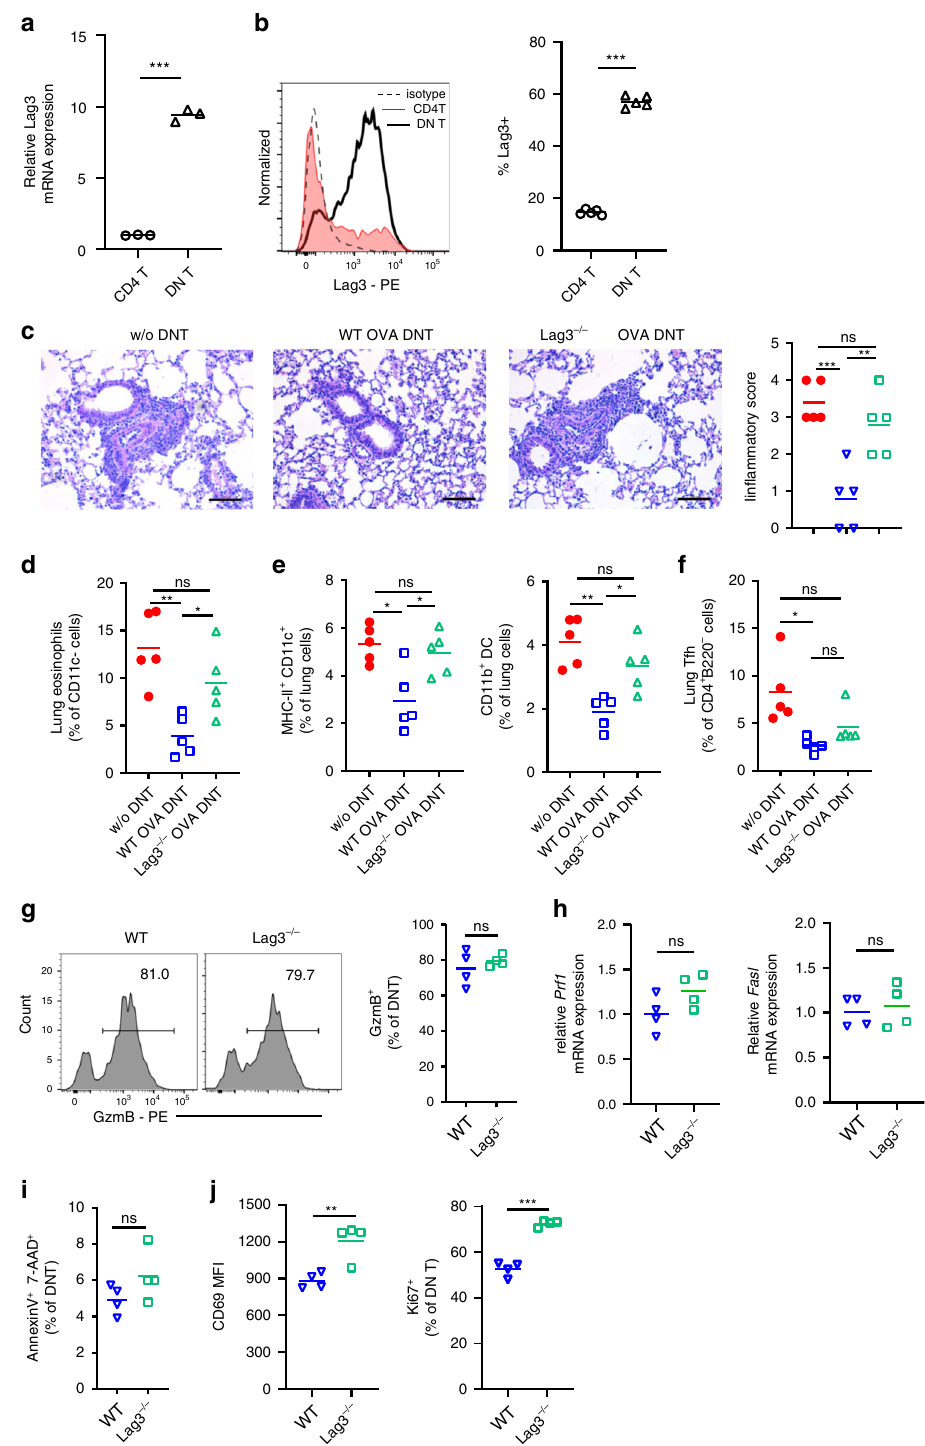
Fig. 6 Lag3 knockout reduced the antigen-speci fi c suppression of OVA DNTs. Relative Lag3 mRNA expression in OVA DNTs and CD4 + T cells was measured by a real-time PCR and b fl ow cytometry. Mice received WT OVA DNTs or Lag3 − / − OVA DNTs by intravenous adoptive transfer to treat OVA-induced airway in fl ammation. c Lung sections were stained with H&E to measure the accumulation of in fi ltrating in fl ammatory cells (Scale bars, 100 μ m). d Lung eosinophils (CD11b + Siglec F + CD11c - ), e DCs (CD11c + MHC-II + ), CD11b + DCs (CD11b + CD11c + MHC-II + ) and f Tfh cells (CD4 + B220 - CXCR5 + PD-1 + ) were assessed by fl ow cytometry. g GzmB expression in WT DNTs and Lag3 − / − DNTs were measured by fl ow cytometry. h Relative Prf1 and Fasl mRNA expression levels in WT DNTs and Lag3 − / − DNTs were measured by real-time PCR. i The apoptosis of DNT cells was detected by fl ow cytometry. j The expression of CD69 and Ki67 were detected by fl ow cytometry. Data are shown as the mean ± SEM; n = 4 – 5 mice per group. One-way ANOVA and Student ’ s t -test were used to calculate signi fi cance. * P < 0.05; ** P < 0.01; *** P < 0.001. Source data are provided as a